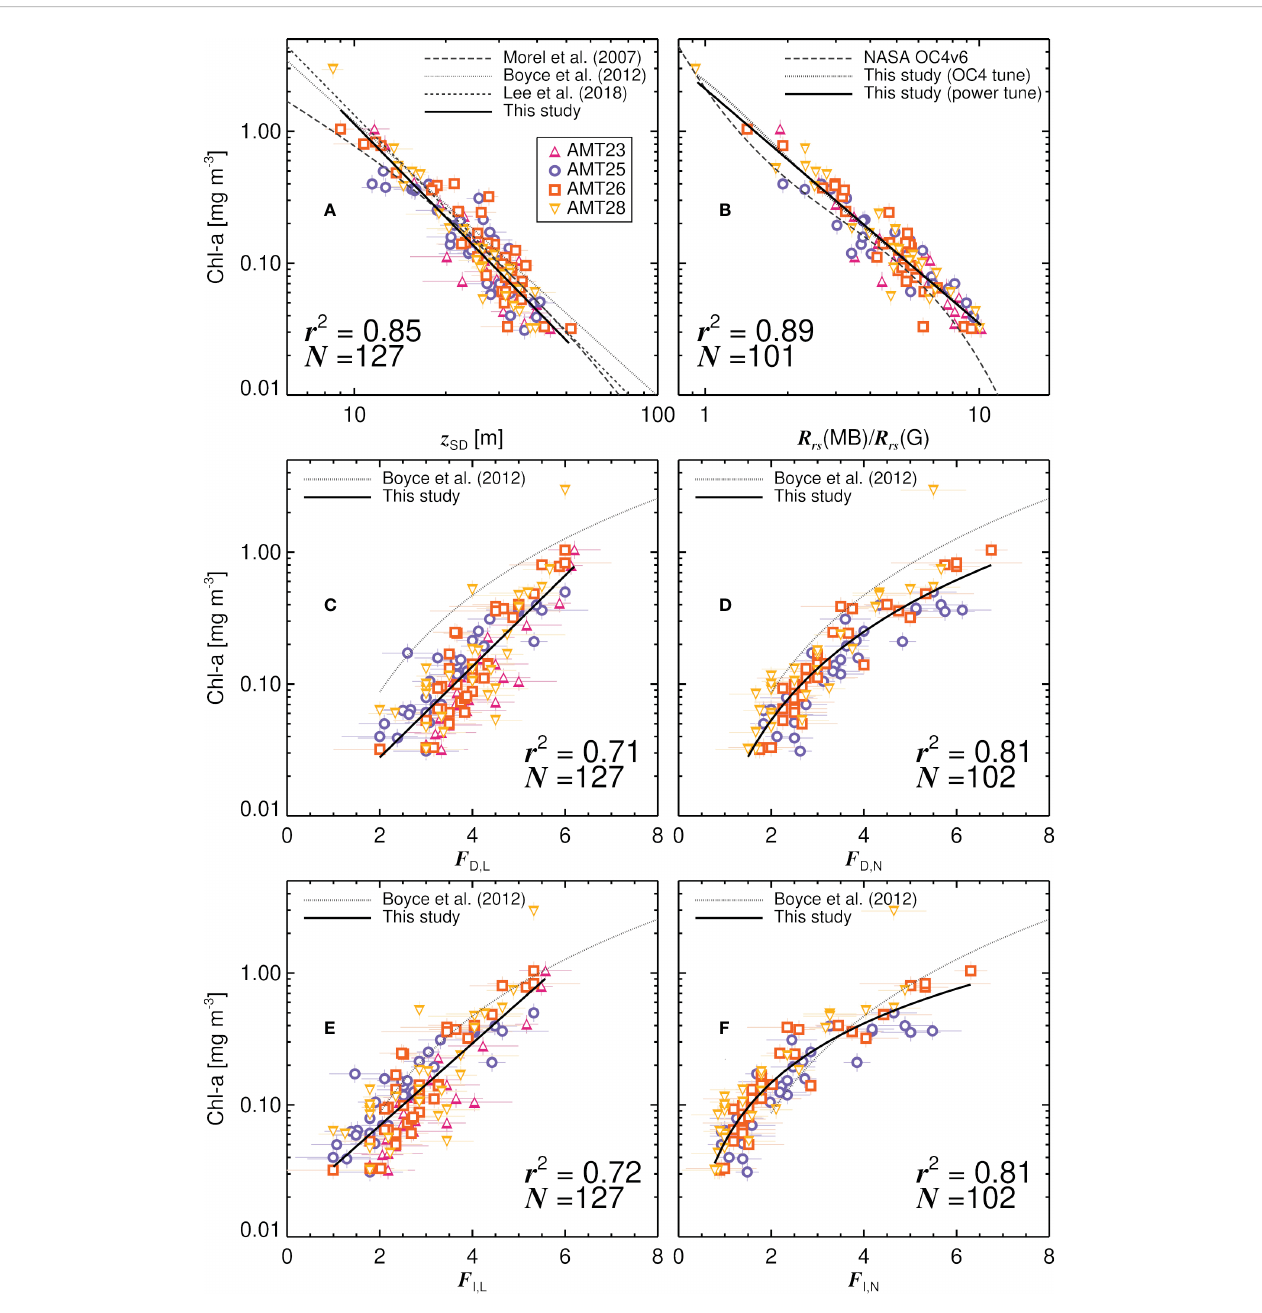
FIGURE 6 Relationship between historical and modern optical properties and the chlorophyll-a concentration (Chl-a) on the four AMT cruises. (A) Comparison of Chl-a and Secchi depth ( z SD ). (B) Comparison of Chl-a and maximum blue-green R rs ratio ( R rs (MB)/ R rs (G)). (C) Comparison of Chl-a and Forel-Ule colour using the LaMotte scale and with reference to the colour of the disk at 1/2 z SD ( F D,L ). (D) Comparison of Chl-a and Forel-Ule colour using the Novoa et al. (2014) scale and with reference to the colour of the disk at 1/2z SD ( F D,N ). (E) Comparison of Chl-a and Forel-Ule colour using the LaMotte scale and with reference to in fi nite water ( F I,L ). (F) Comparison of Chl-a and Forel-Ule colour using the Novoa et al. (2014) scale and with reference to in fi nite water ( F I,N